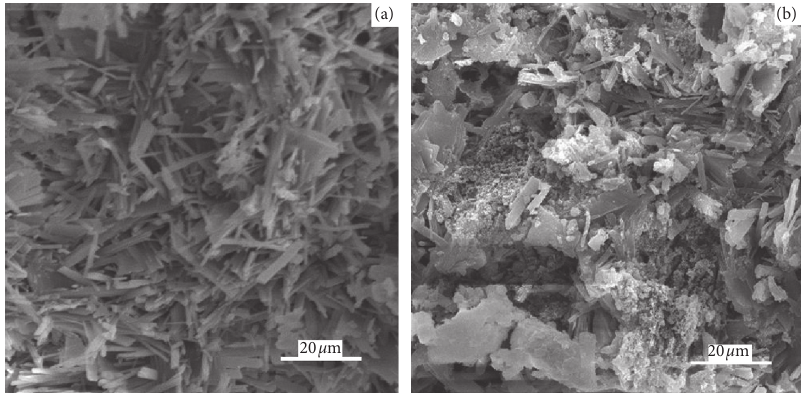
Figure 9: Microstructure of hardened CP (a) and hardened CAP (b).